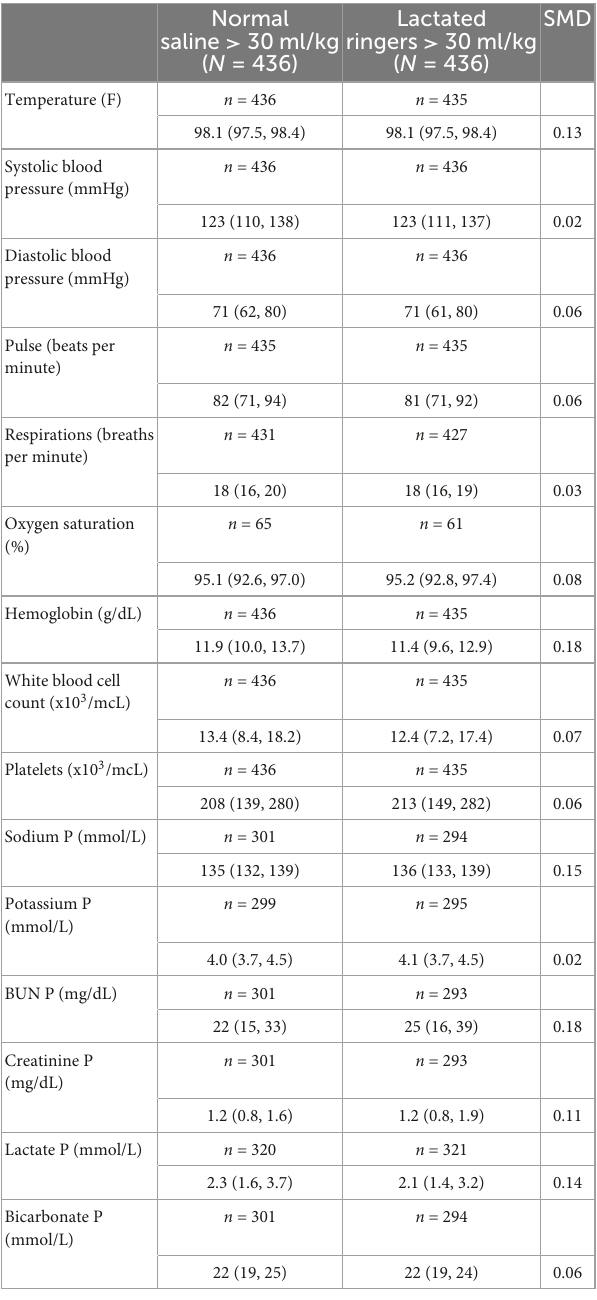
TABLE 1B Baseline vital signs and laboratory information of RL and NS cohorts after